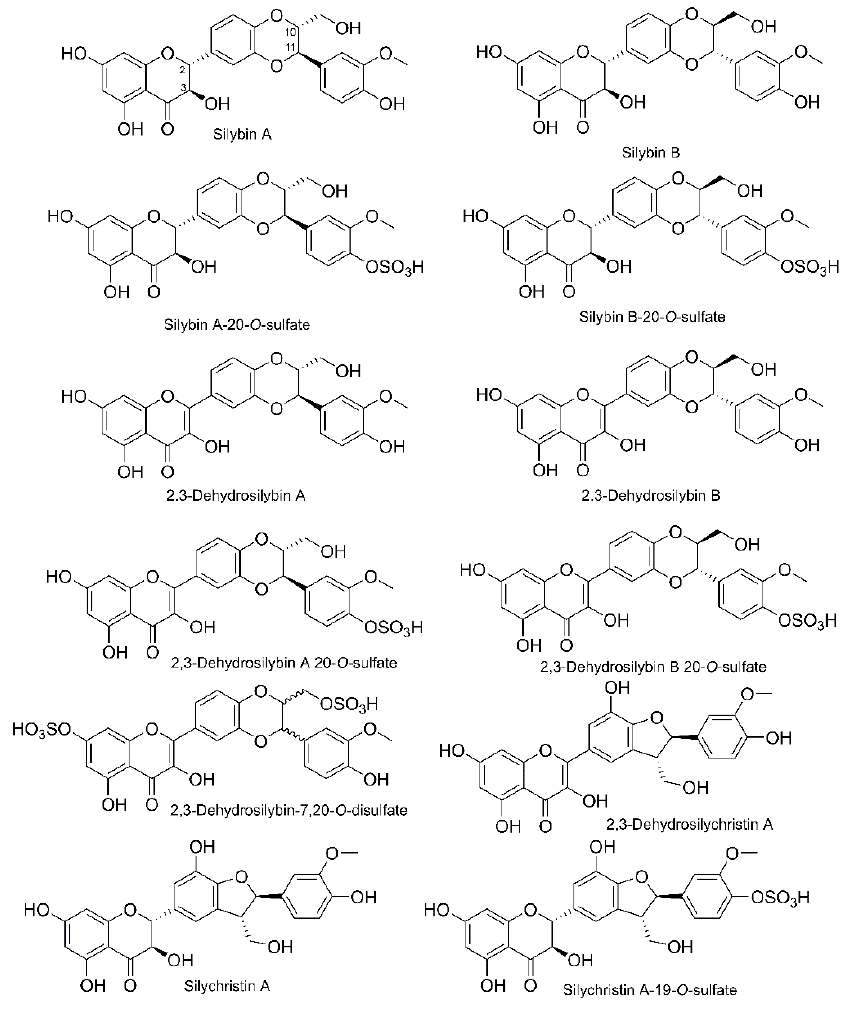
Figure 1. Structures of the compounds tested.